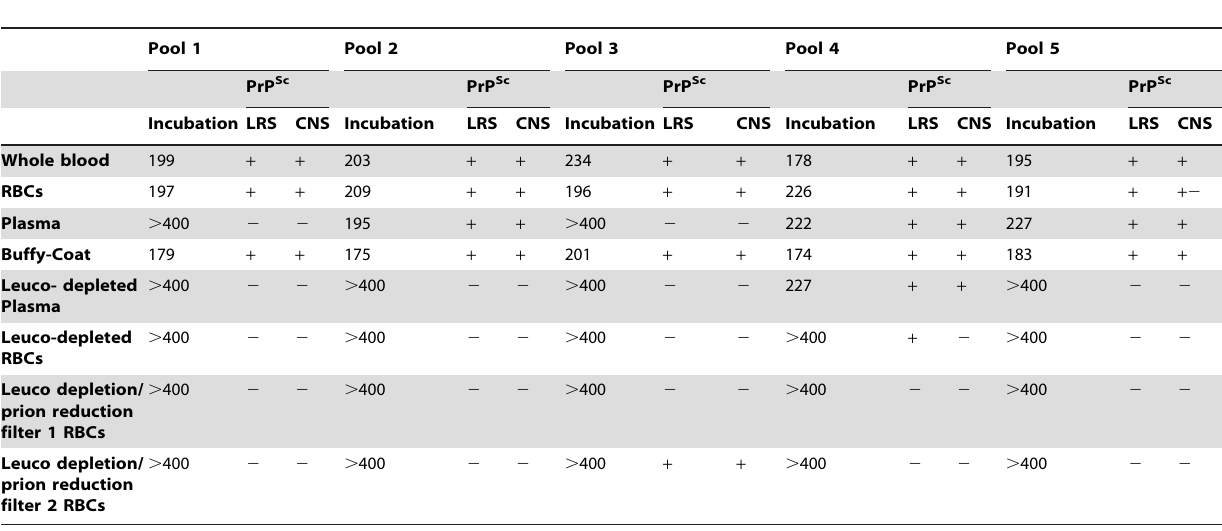
Table 3. TSE occurrence in VRQ/VRQ TSE free sheep transfused with blood labile products prepared from Scrapie infected sheep.